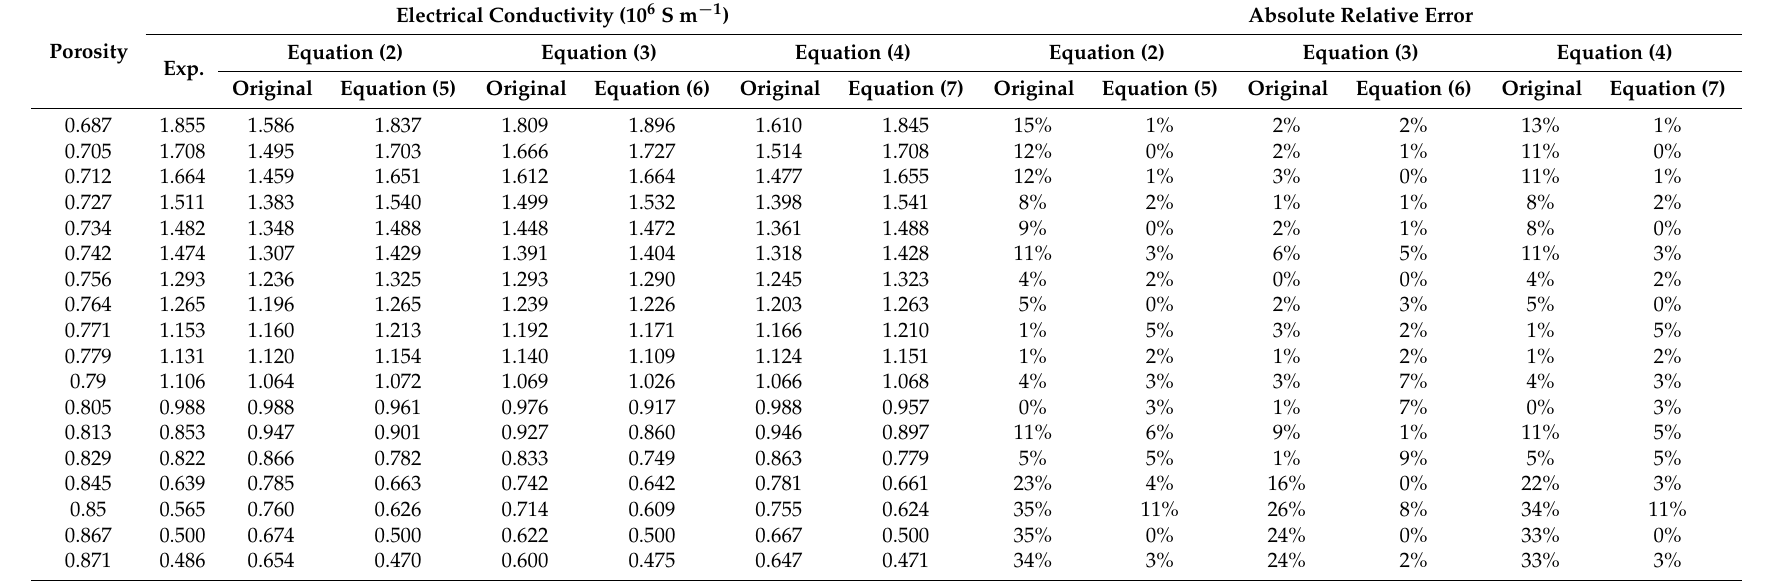
Table 2. Experimental data from Feng et al. [30] and calculated values of electrical conductivity of Al-alloy foams using different